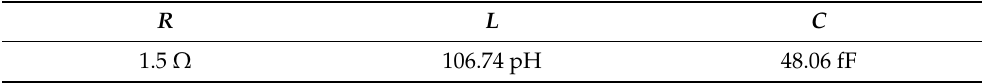
Table 4. Extracted RLC lumped element values from InGaAs/InP UTC-PD Open and Thru test